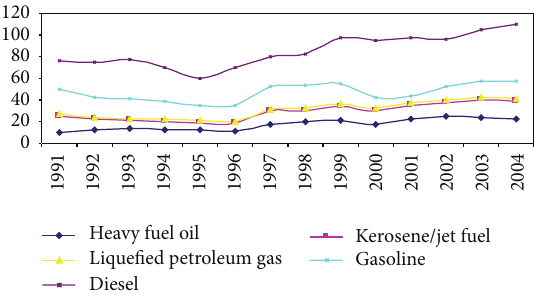
Figure 3: Petroleum consumption (10 2 tonnes) from 1991 to 2004